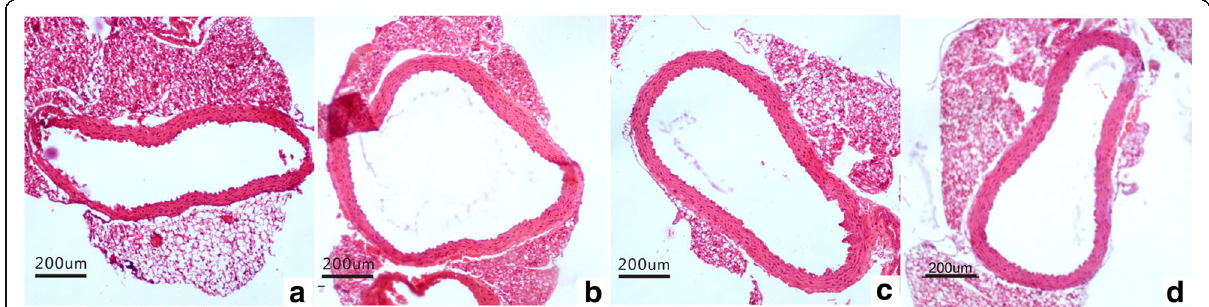
Fig. 5 Representative images of thoracic aorta remodeling in different groups of mice (HE staining, magnification ×200). ( a )Sham group; ( b ) Model group; ( c ) XJEK group; ( d ) Fosinopril group